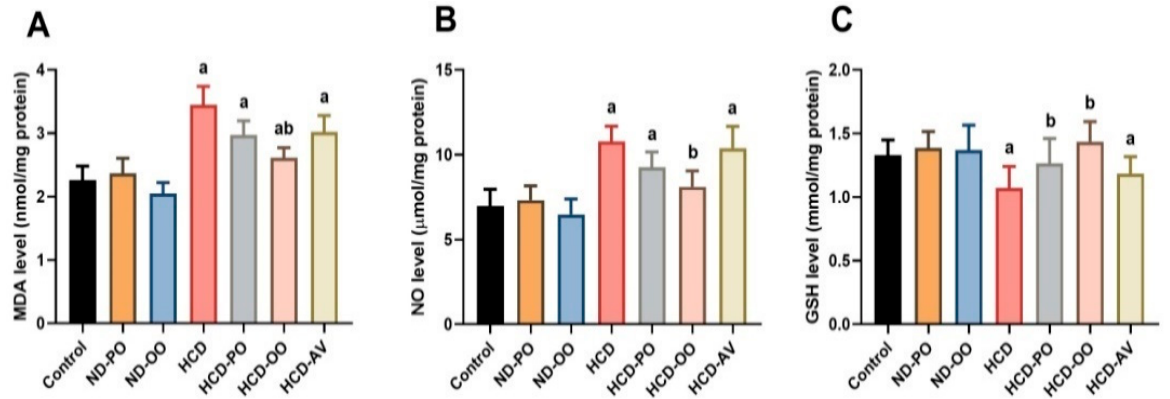
Figure 5. Hepatic levels of oxidative stress markers (( A ) lipid peroxidation, ( B ) nitric oxide, and ( C ) glutathione) following treatment with palm oil (PO), olive oil (OO), or atorvastatin (AV) in high-cholesterol diet-induced hypercholesterolemia in rats.Data are expressed as the mean ± SD ( n = 7). Letters a and b indicate statistically significant differences between control rats and hypercholesterolemia rats, respectively, at p < 0.05.